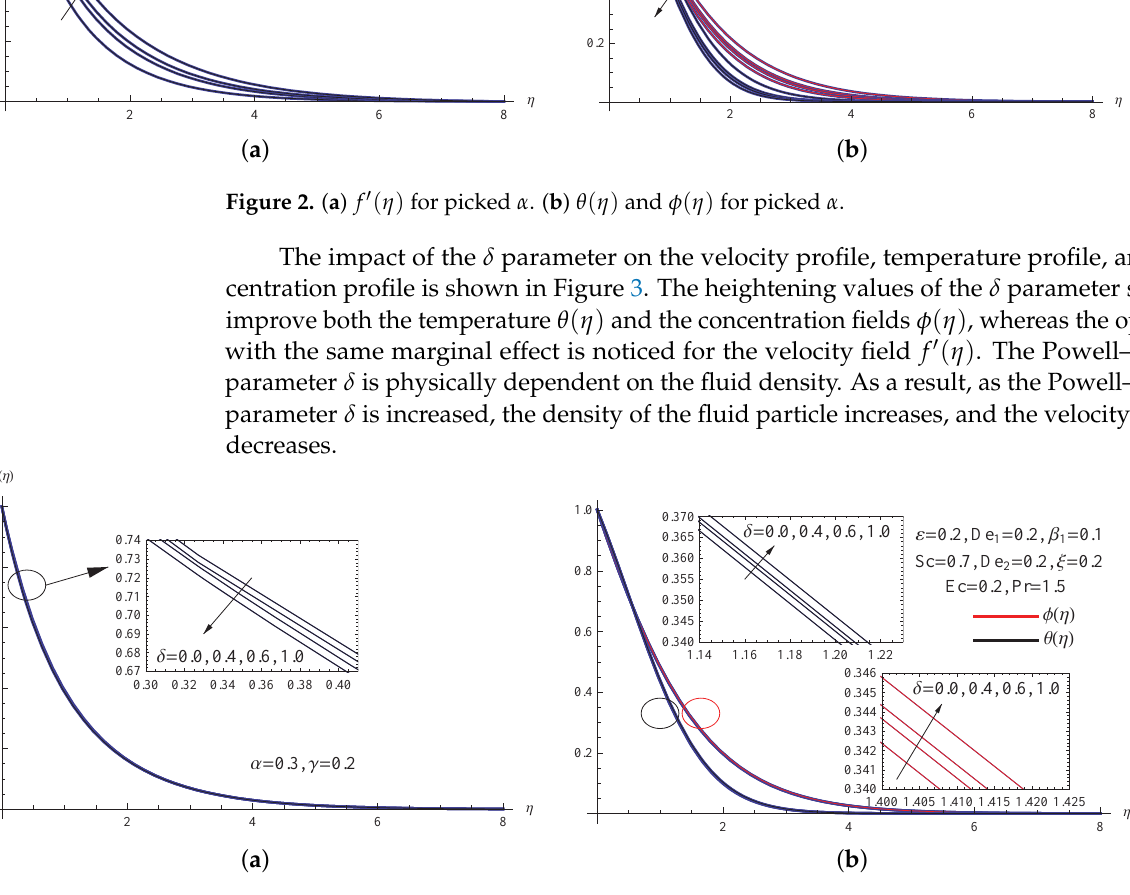
Figure 3. ( a ) f (cid:48) ( η ) for picked δ . ( b ) θ ( η ) and φ ( η ) for picked δ . Figure 4 is plotted to examine the velocity profiles f (cid:48) ( η ) , the temperature profiles θ ( η ) and the concentration fields φ ( η ) , for expanding values of the viscosity parameter γ . The dependence of fluid viscosity on the temperature through the presence of γ invigorates both the fluid temperature θ ( η ) and the fluid concentration φ ( η ) distribution, while the presence of the γ parameter hinders the liquid velocity f (cid:48) ( η ) through the boundary layer. Physically, increasing the magnitude of the viscosity parameter acts as a retarding factor, causing the fluid velocity to slow down and, as a result, the friction between the fluid layers increases, causing the fluid temperature to enhance. Figure 5 has been portrayed to delineate the impact of the thermal conductivity parameter ε . The larger values of the thermal conductivity parameter ε relate to the larger temperature distribution and marginal increments in the concentration field, while the growth in a same parameter makes insignificant decreases in the speed profiles. Physically, increasing the value of ε enhances the fluid thermal conductivity, which increases both the fluid temperature and the thickness of the thermal